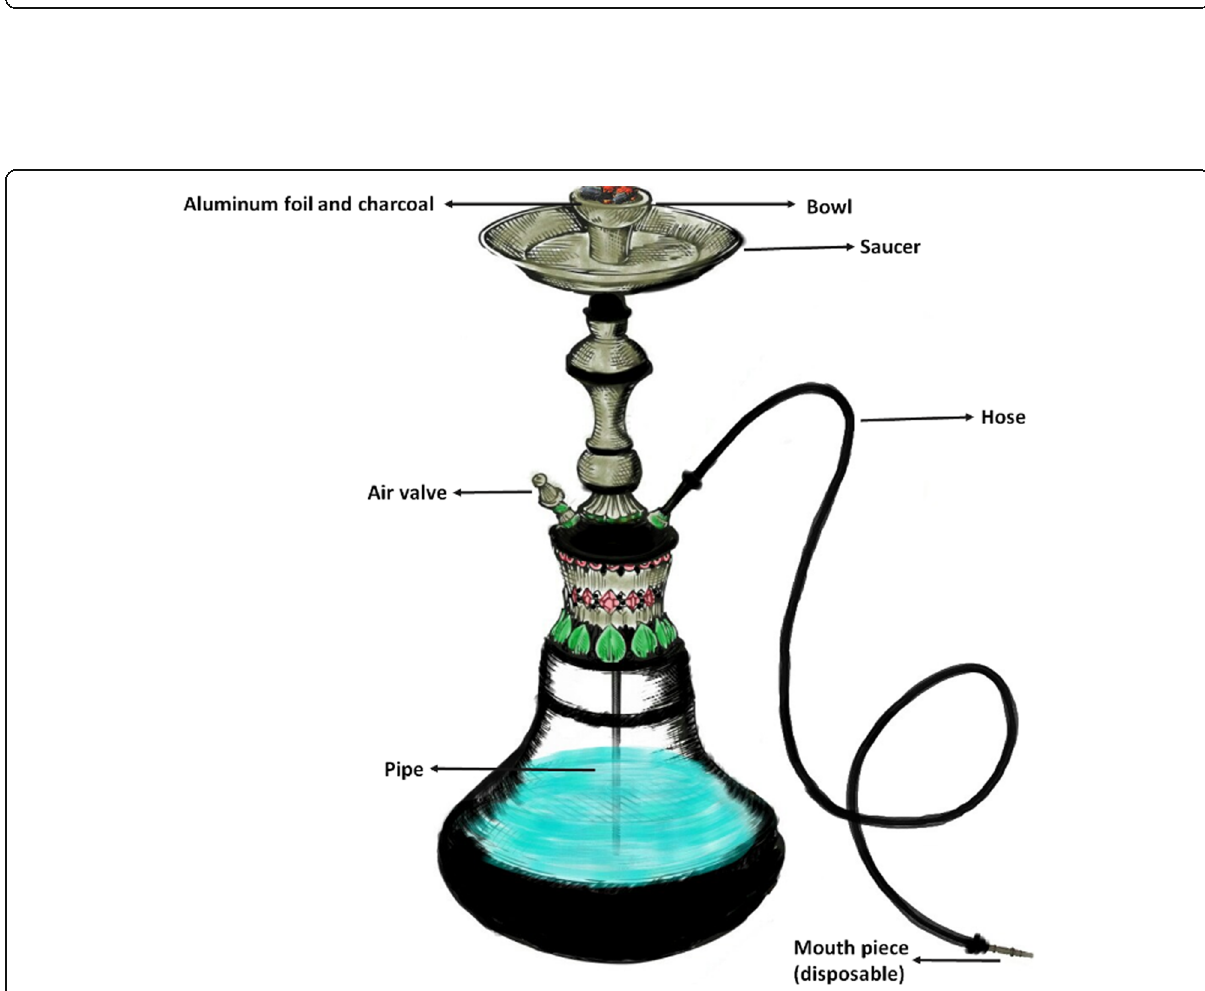
Fig. 2 A typical hookah